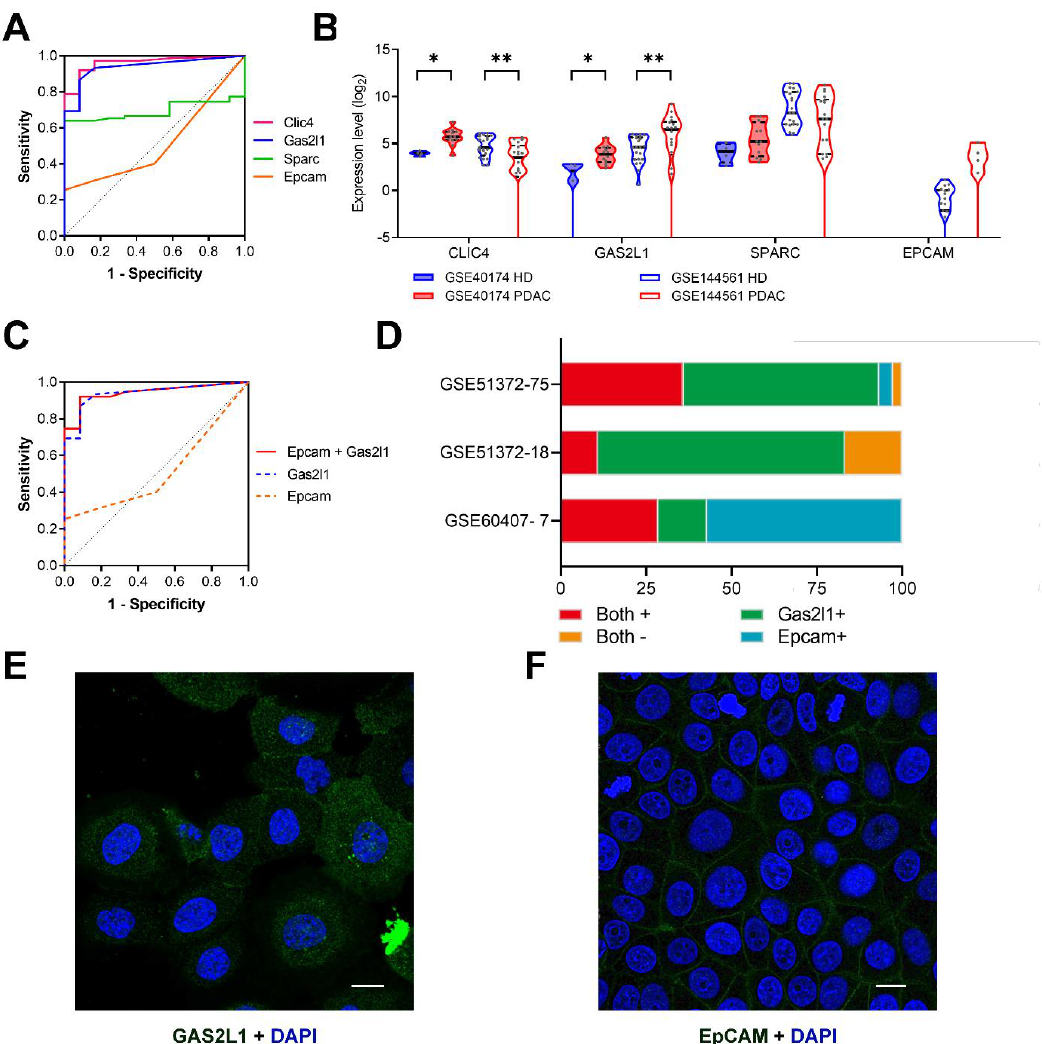
Figure 5. T Gas2l1 is a potential marker for pancreatic circulating tumor cells (CTCs). ( A ) Receiver operator characteristic (ROC) analysis of markers in murine samples (GSE51372). ( B ) The violin plots reflect the expression level of CLIC4 , GAS2L1 , SPARC , and EPCAM in human blood samples (GSE40174 and GSE144561). *, p < 0.050; **, p < 0.001. ( C ) The ROC curve reflects the combination of Gas2l1 and Epcam in murine samples (GSE51372). ( D ) The stacked bars show the Gas2l1 and Epcam expression ratio in 75 murine pancreatic CTCs (GSE51372) and two validation datasets (18 GFP-Tagged murine CTCs from GSE51372 and 7 human pancreatic CTCs from GSE60407). The subcellular location of GAS2L1 ( E ) and EPCAM ( F ) in human cell lines (A-431 and MCF7, respectively); scale bar, 20 µ m. Blue, nucleus; Green, antibody. These two pictures were obtained from the Human Protein Atlas (https://www.proteinatlas.org/). AUC, area under curve; EPCAM , epithelial cell adhesion molecule; HD, healthy donor; PDAC, pancreatic ductal adenocarcinoma; ROC, receiver operator characteristic. Table 1. Expression of GAS2L1 in CTC samples.